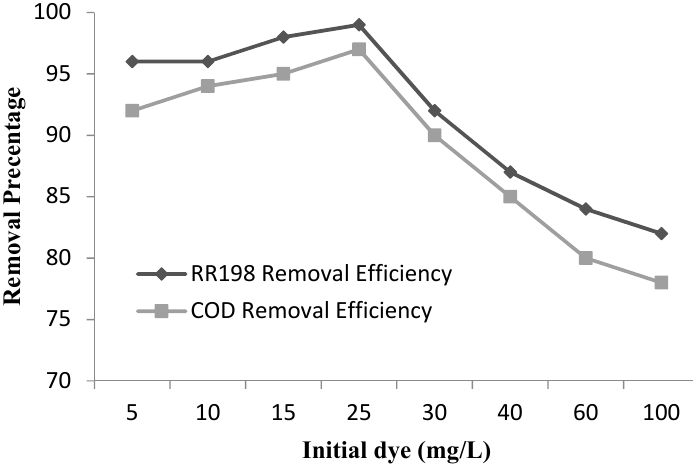
Figure 8. Effect of initial dye on RR198 and COD removal efficiencies, optimum conditions: [PS = 5 mM, catalyst dosage = 0.3 g/L, reaction time: 25 min, and pH= 6.5].